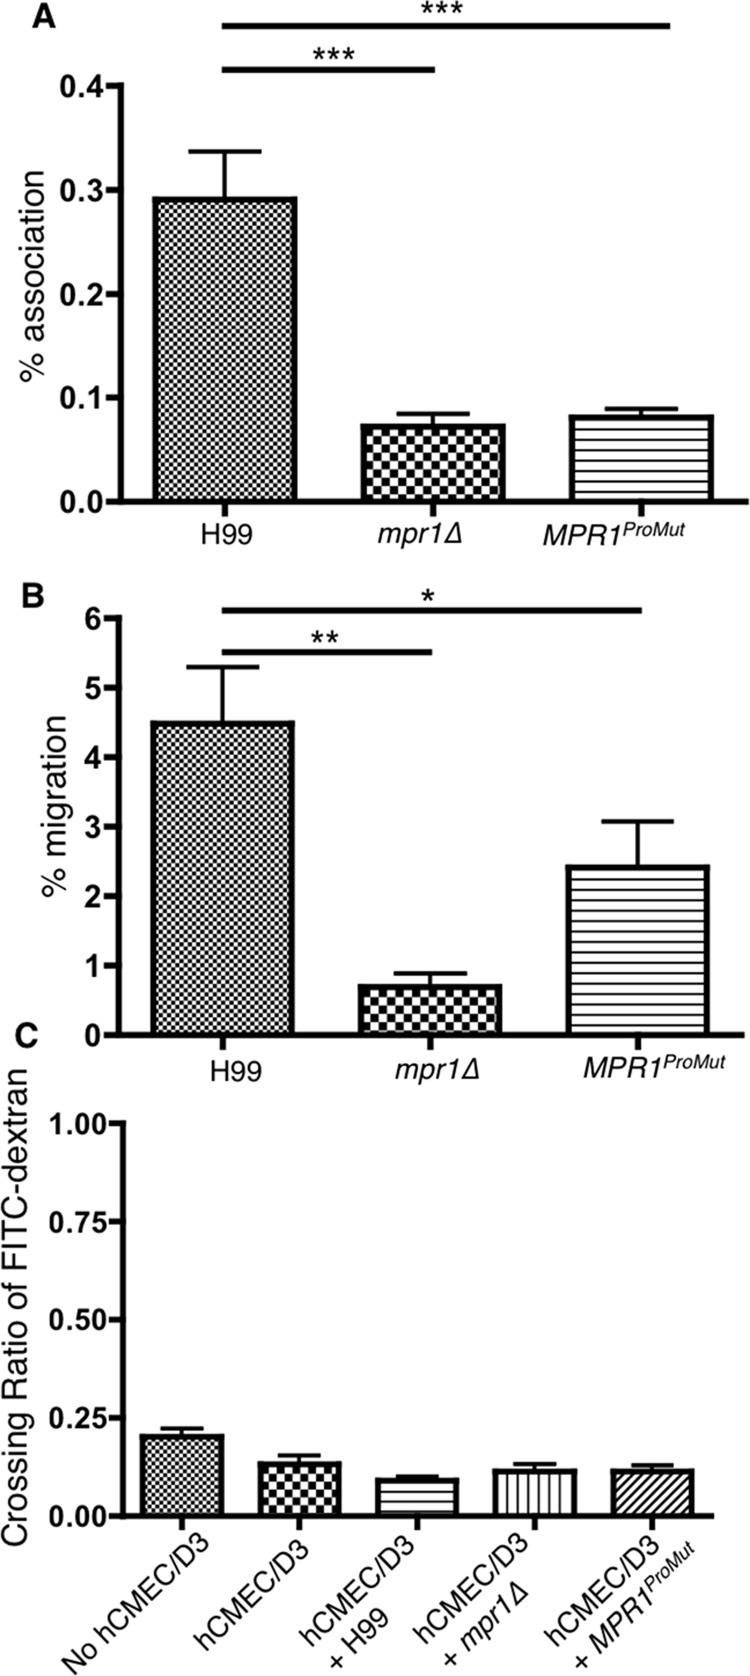
The expression of the MPR1 mutations at sites D353 and D355 in C. neoformans reduces fungal association with brain endothelial cells and prevents fungal transcytosis across the BBB.(A) Following a 1h co-incubation of H99, mpr1Δ, or MPR1ProMut-Myc strain with brain endothelial cells, association assays revealed a significant decrease in the adherence of the CnMPR1ProMut-Myc strain to the BBB (P< 0.05, n = 8). (B) Cryptococci expressing MPR1ProMut-Myc displayed a significant decrease in BBB crossing in contrast to H99 and the mpr1Δ deletion strain (P<0.05, n = 8). (C) The integrity of the barrier in the vitro model of the human BBB remains intact during transcytosis assays. The FITC-dextran permeability assays revealed that the cellular junctions of the brain endothelial cells in the in vitro model of the BBB are not compromised during transcytosis assays indicated by the low FITC-dextran ratios (P> 0.05, n = 8).